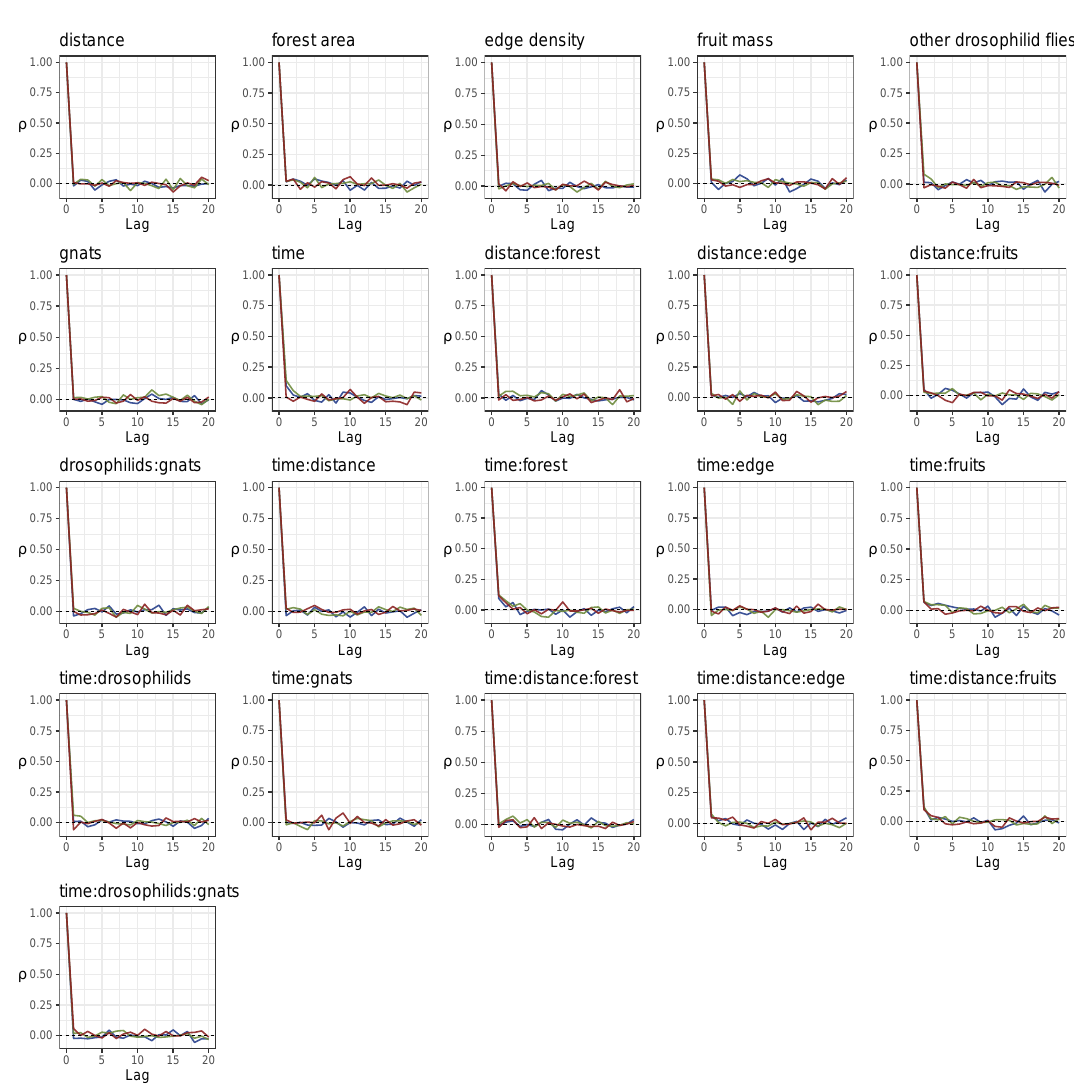
Figure A6. Autocorrelation plots from posterior draws of parameters in each chain. Please note that the variable time is represented by calendar weeks and burnins are